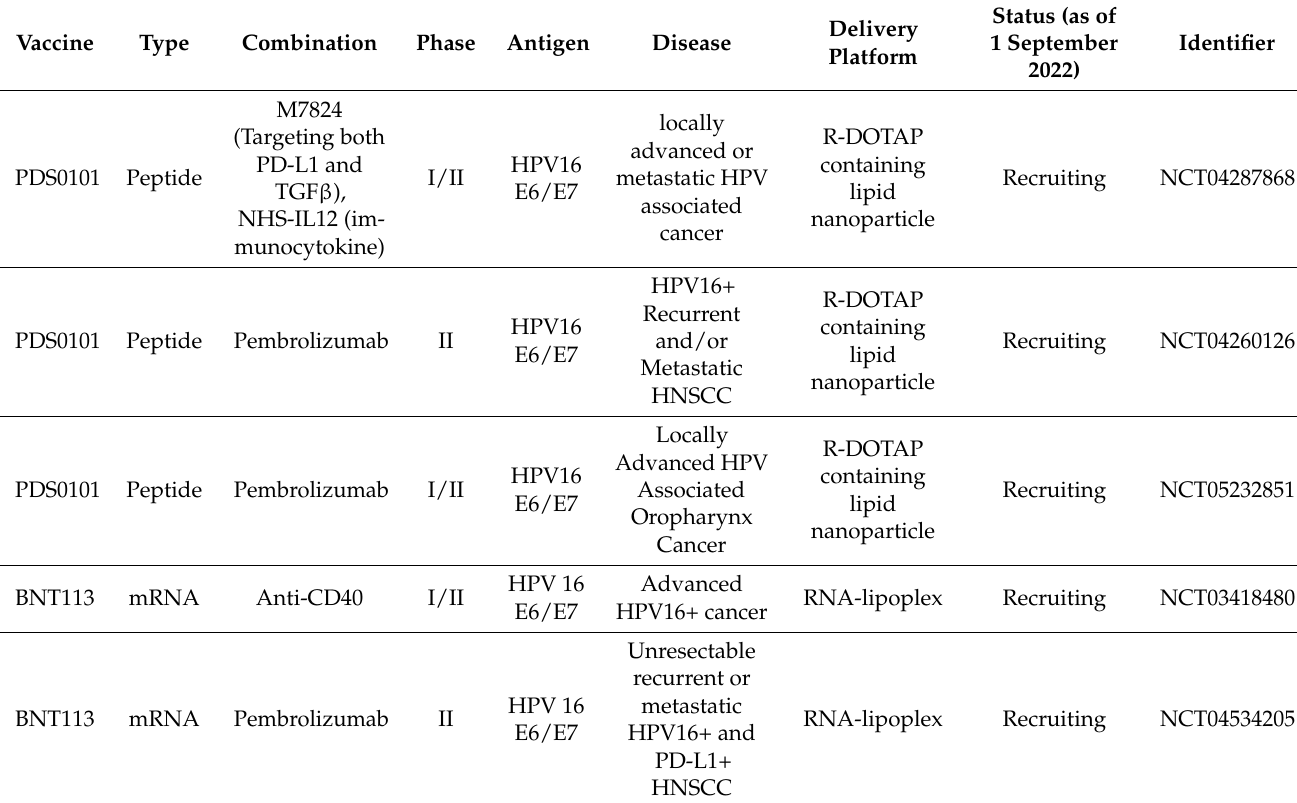
Table 1. Nanovaccine clinical trials studies for HPV-related